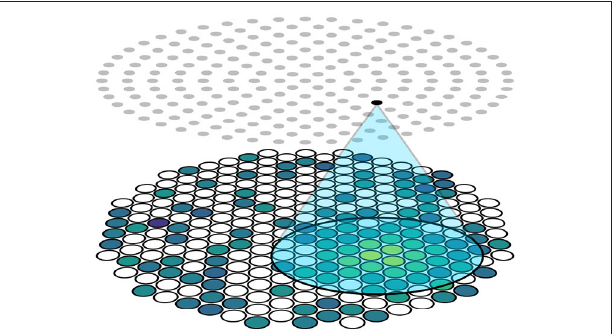
FIGURE 3 | Schematic of the locality constraint. The distance between the highlighted neuron and photosensors in the blue area is smaller than a threshold. Photosensors inside the blue area are connected to the highlighted neuron while photosensors outside the blue area are not, limiting the receptive field of the highlighted neuron to be the blue area.